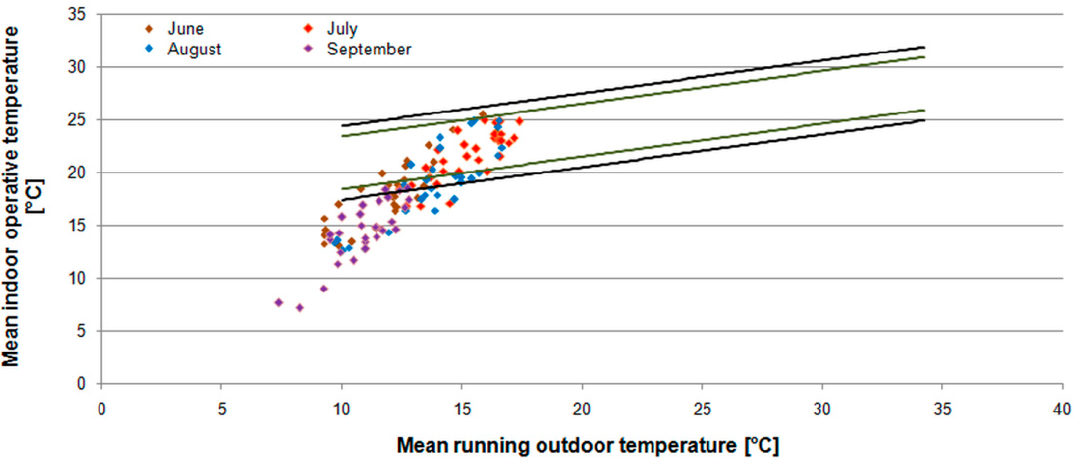
Figure 9. Comfort zone of EN 15251 and daily operative temperature in analyzed months in the case 2 of the building. Category I: green lines, Category II: black lines.